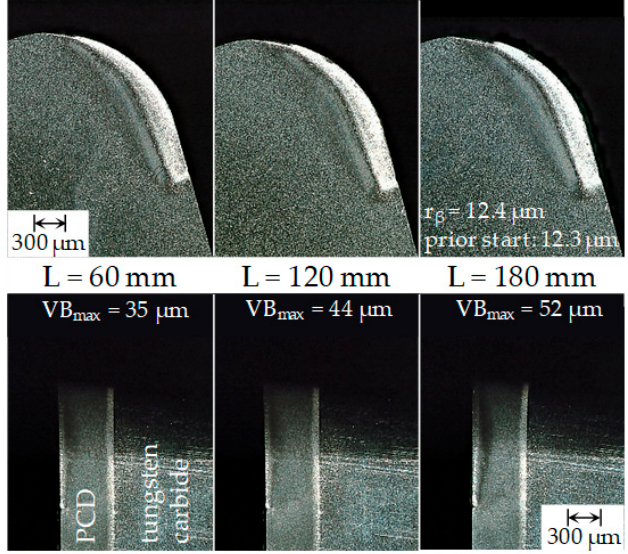
Figure 9. PCD cutting insert (external flood cooling, flow rate 22 L/min).